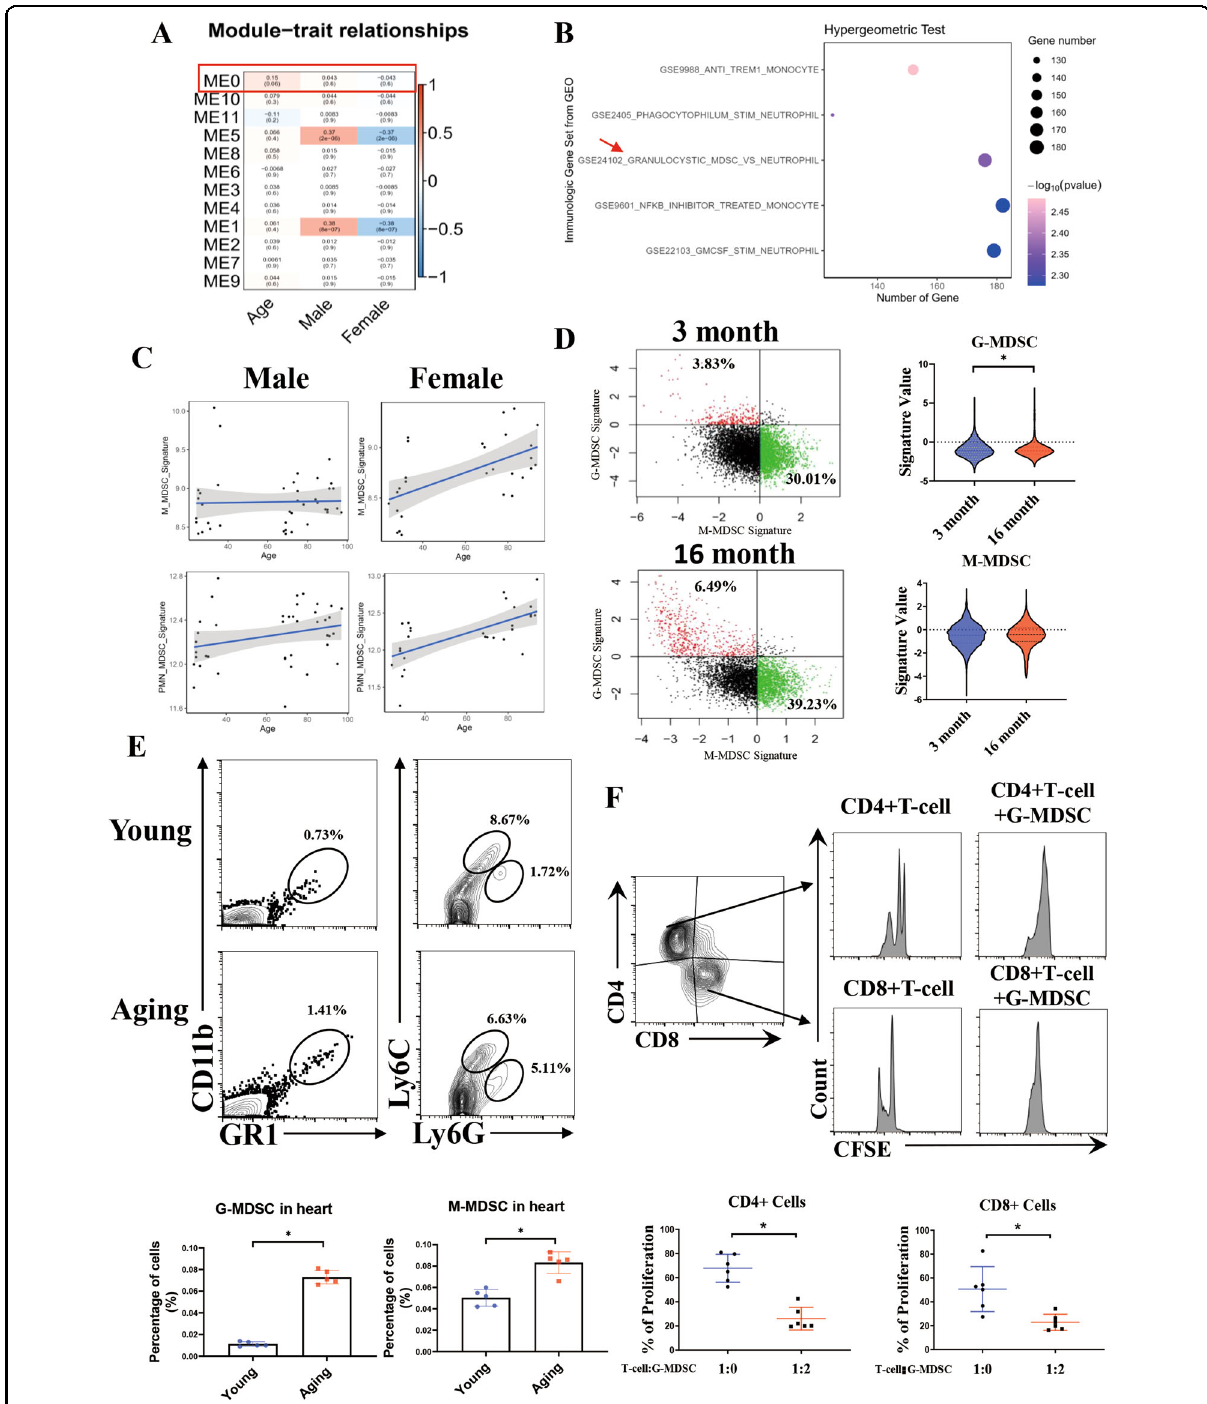
Fig. 1 Levels of MDSCs in the heart are positively associated with age. A WGCNA of the coexpressed genes from 135 human whole blood transcriptomes from the GEO database (GSE123698). ME0 was related to age (correlation coef fi cient = 0.15) but not to sex (correlation coef fi cient = 0.043). Red indicates a positive correlation, and blue indicates a negative correlation. B Hypergeometric test of the genes in ME0 based on the immunologic gene set from GSE123698. The size of the dot represents the number of genes. A darker color indicates a lower correlation. C The bubble plots show the correlation between the G-MDSC/M-MDSC signature and age in males and females based on GSE123698. D The ratio (left) and signature value (right) of the G-MDSCs and M-MDSCs in 3- month-old and 16-month-old mice determined by scRNA-Seq analysis (GSE145477). E Representative fl ow cytometric pro fi le showing the quantitative analysis of Cd11b + Gr1 + Ly6G + cells and Cd11b + Gr1 + Ly6C + cells in the hearts of young and aging mice; n = 5 per group. F CFSE-labeled CD4 + and CD8 + T cells and G-MDSCs separated from hearts were cocultured at a ratio of 2:1 for 24h. Representative images and quantitative analysis of the proliferation of CD4 + or CD8 + T cells analyzed by fl ow cytometry; n = 6 per group. The data are presented as the means±SDs. Differences were determined by Student ’ s t test. * P